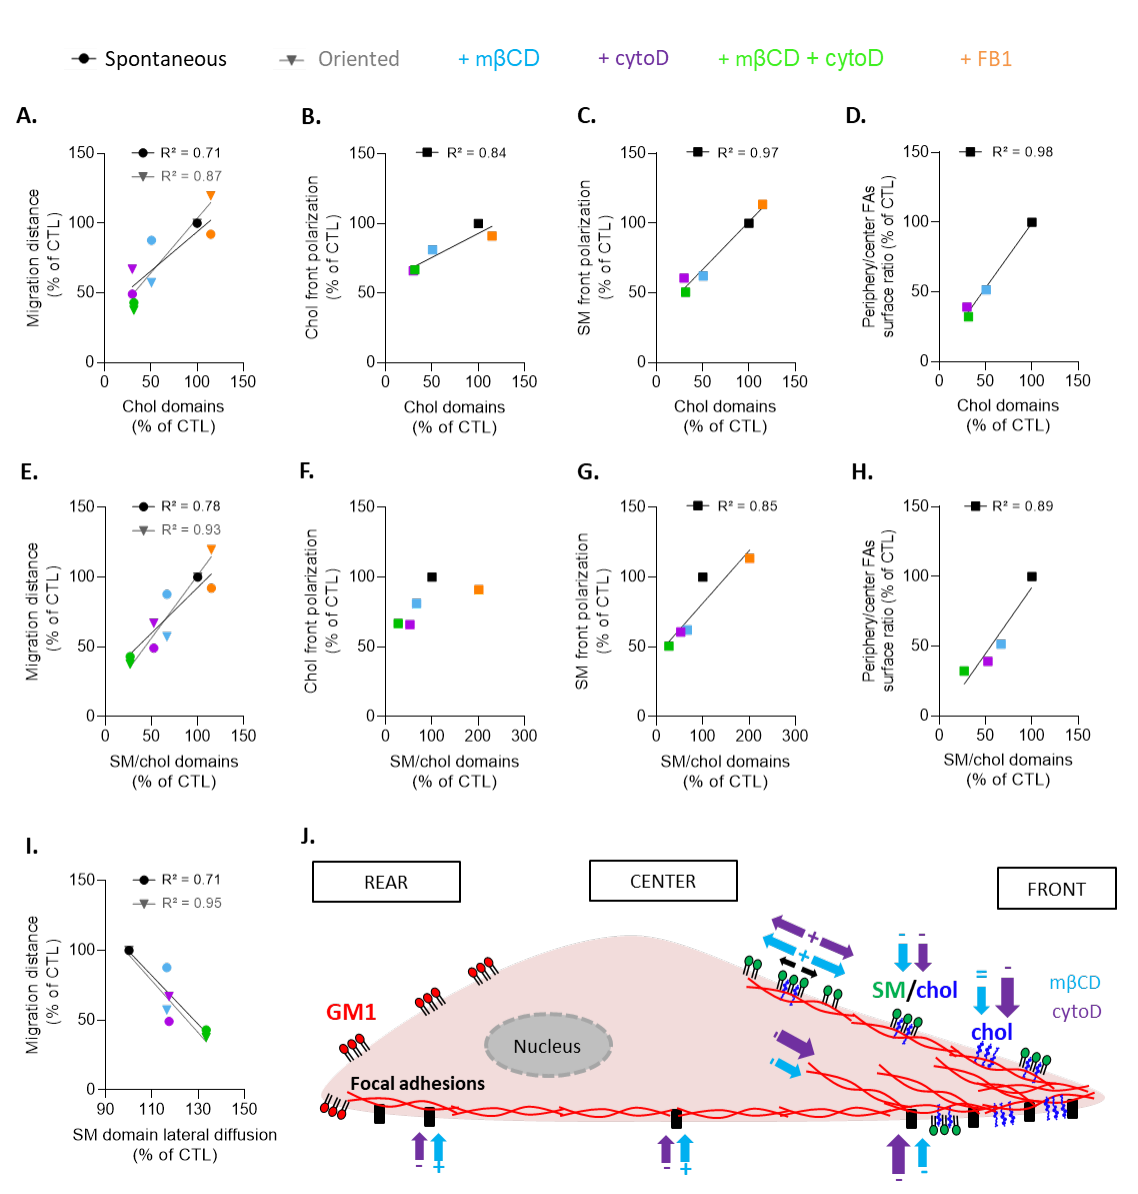
Figure 11. Relations between myoblast migration, polarization of cholesterol and sphingomyelin at the front or focal adhesions peripheral distribution on one hand, and chol- and SM/chol-enriched domain proportion or SM lateral diffusion on the other hand, and hypothetical model. ( A – H ) Positive linear correlations of chol-enriched domains ( A – D ) or SM/chol-enriched domains ( E – H ) with my- oblast spontaneous (black circles) and oriented (gray triangles) migration ( A , E ), chol and SM polariza- tion at the migration front ( B , C , F , G ) and the ratio of periphery vs. center FAs surface occupancy ( D , H ). ( I ) Negative linear correlation of SM-enriched domains lateral diffusion with myoblast spontaneous and oriented migration. Regression and R 2 are indicated on the graph only if >0.5. ( J ) Hypothetical model. While GM1-enriched domains polarized at the rear (red), chol (dark blue)- and SM/chol (green/dark blue)-enriched domains polarized at the front in proximity with the actin cytoskeleton (red) and SM-enriched domains presented a restricted lateral mobility (black arrows). Chol depletion by m β CD impaired SM polarization as well as F-actin and FA (black rectangles) polarization in favor of a distribution at the center and rear of the cell (blue arrows). Actin cytoskeleton impairment by cytoD abrogated the effects of m β CD on SM polarization and FA distribution (purple arrows). In contrast, the combination of m β CD and cytoD increased the lateral mobility of SM associated with domains (purple and blue arrows). Size of arrow reflects the extent of the effect: (+), increase; ( − ), decrease; (=), no